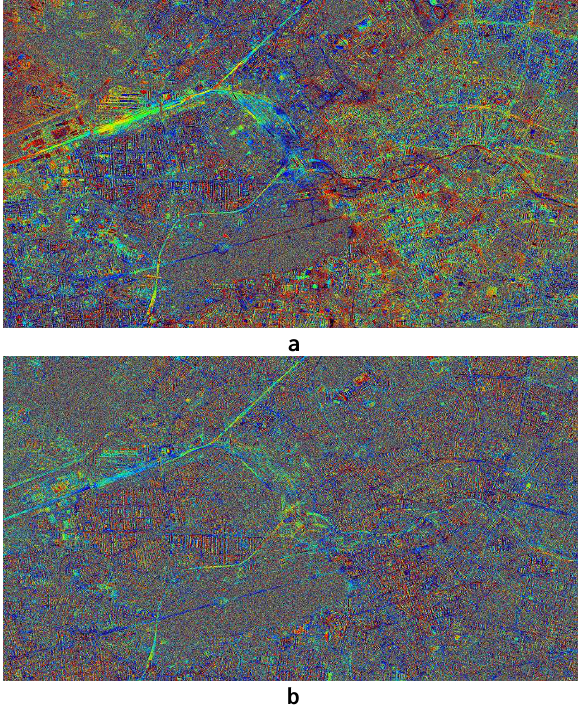
b Figure 2. Generated Interferograms